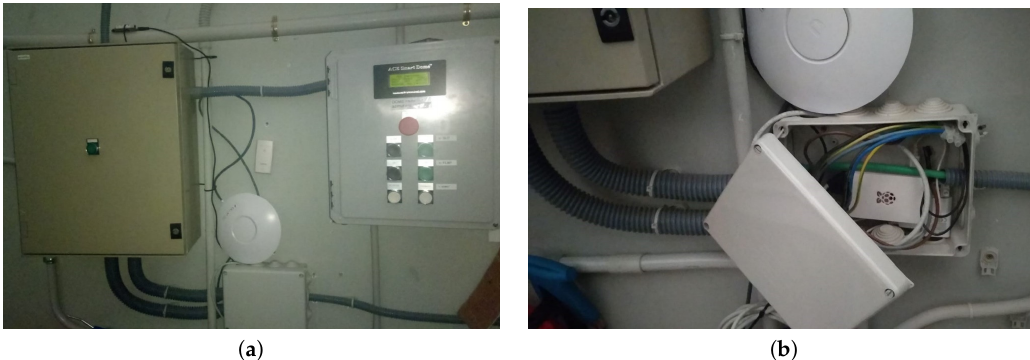
Figure 14. Location of both collector node and raspberry board. ( a ) General view. ( b ) Distribution panel view.